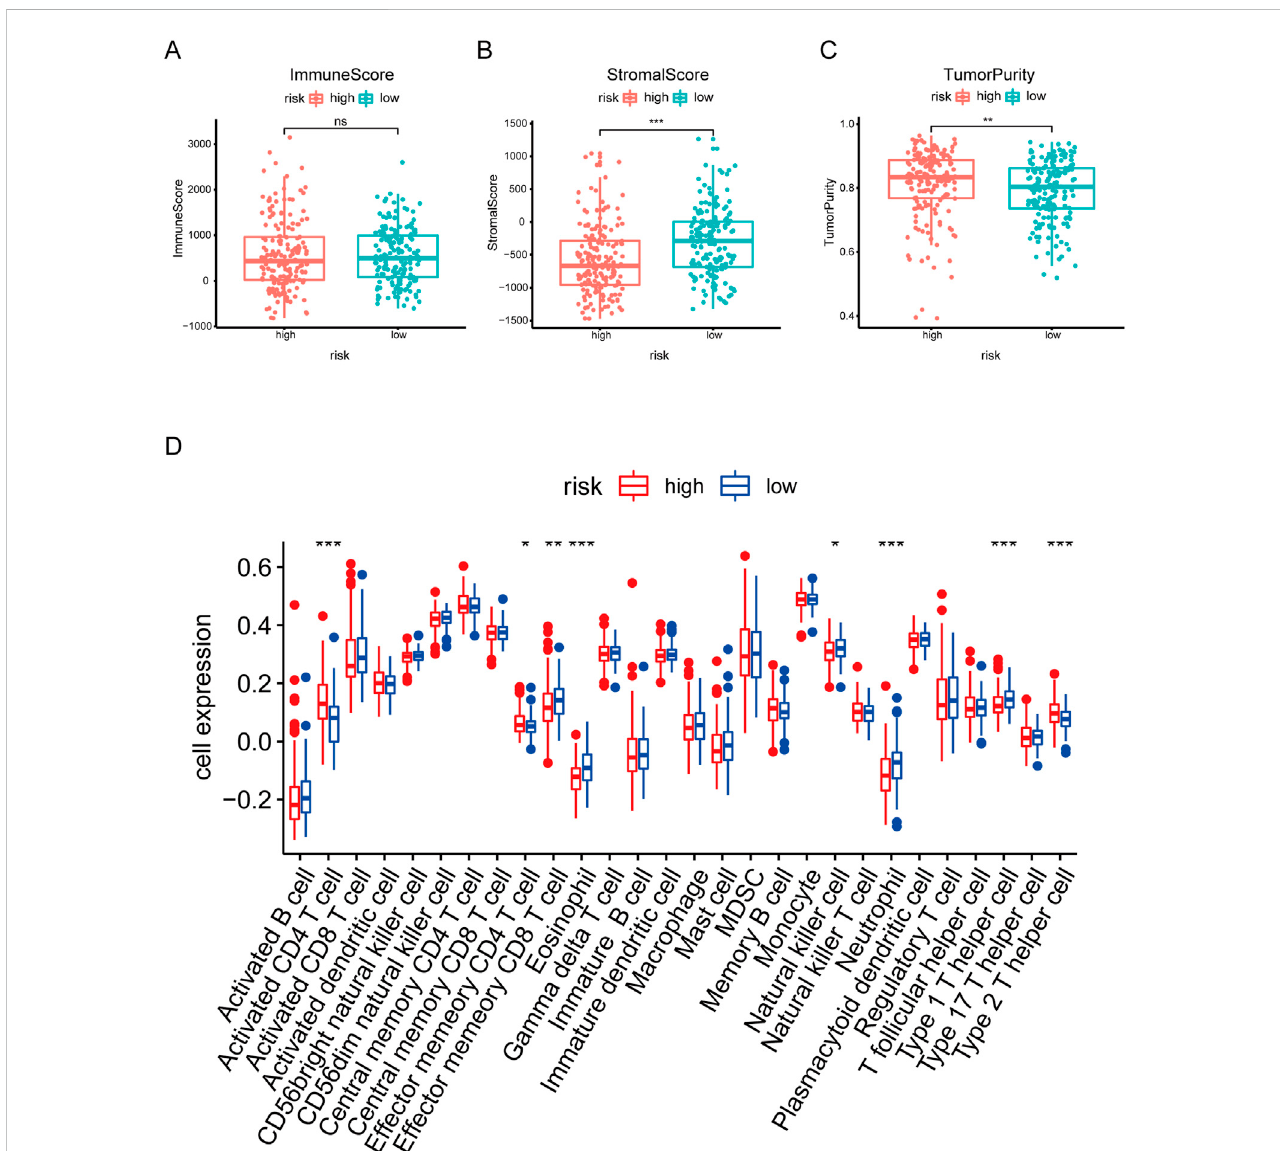
Correlation analysis between risk score and Immune in fi ltration in HCC. (A – C) Box plot of differences in immuneScore, StromalScore TumorPurity between high- and low-risk groups. (D) Box plot of differences in immune cell in fi ltration in high- and low-risk groups. * p < .05. ** p < .01. *** p <